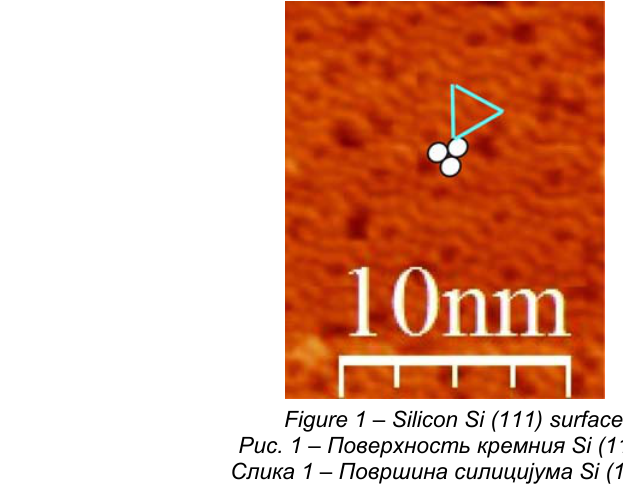
Figure 1 – Silicon Si (111) surface Рис . 1 – Поверхность кремния Si (111) Слика 1 – Површина силицијума Si